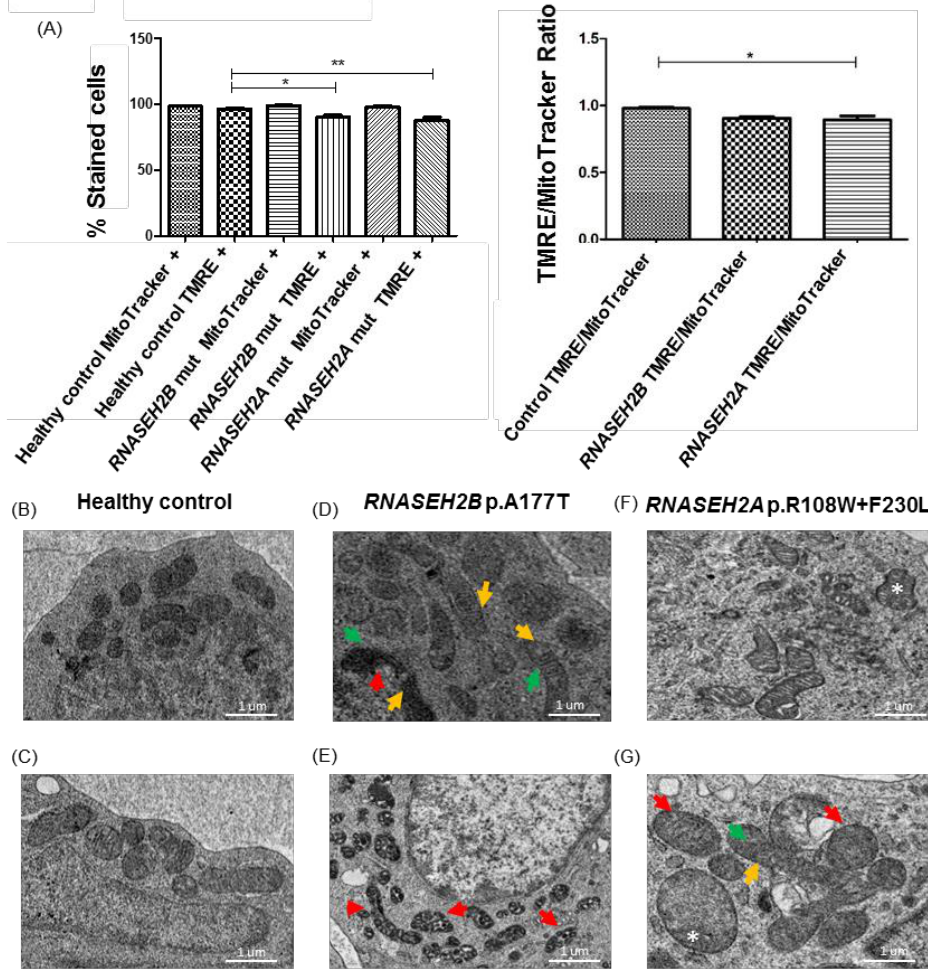
Figure 1. Mitochondria functionality and morphology of RNASEH2-mutated LCLs and healthy con- trol. ( A ) Quantification of the TMRE and MitoTracker TM signals and TMRE/Mitotracker Ratio from three independent experiments. MitoTracker TM positive mitochondria represent the total number of mitochondria present in the cells. TMRE positive mitochondria represent the percentage of mito- chondria with a not altered membrane potential in mutated RNASEH2B (p.A177T) and RNASEH2A (p.R108W + p.F230L) LCLs compared to the healthy control. The bar graph represents the mean of three biological experiments. ANOVA test and post hoc analysis Tukey ’ s Test have been performed. * p < 0.05, ** p < 0.01. ( B – G ) Representative TEM images of mitochondria from AGS patients carrying mutations in RNASEH2B ( D , E ) and RNASEH2A ( F , G ) genes show alterations of the physiological morphology. Mitochondria have unusual shapes (green arrows) ( D , G ) with packed cristae or over- laid layers of membranes (red arrows) ( D , E , G ) or with a longitudinal shape (yellow arrows) ( D , G ). Some mitochondria are enlarged and loss of cristae is observed (asterisk) ( F , G ).